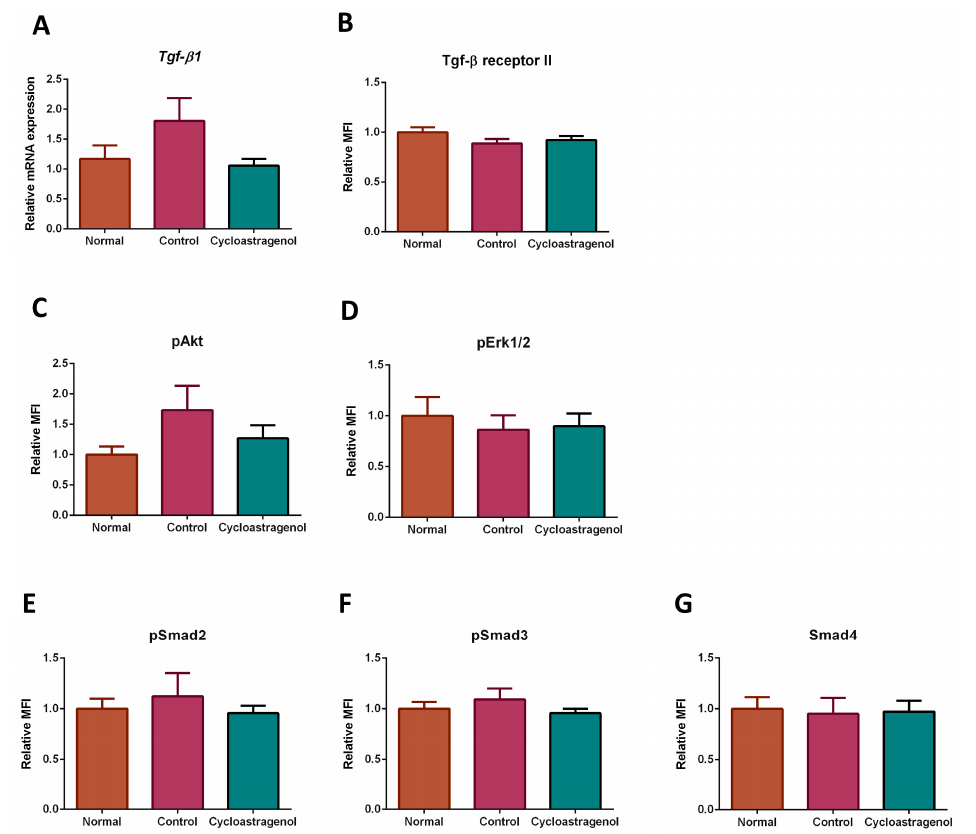
Figure 9. Effects of cycloastragenol (200 mg/kg) on the expression of markers associated with transforming growth factor-beta 1 (TGF- β 1) signaling in the liver of mice treated with carbon-tetrachloride. Relative mRNA expression of TGF- β 1 ( Tgf- β 1 , ( A )) and relative median fluorescence intensity (MFI) of transforming growth factor-beta receptor II (Tgf- β receptor II, ( B )), phosphorylated protein kinase B (pAkt, ( C )), phosphorylated extracellular signal-regulated kinase 1/2 (Erk1/2, ( D )), phosphorylated-Smad2 (pSmad2, ( E )), phosphorylated-Smad3 (pSmad3, ( F )), and Smad4 ( G ) when compared with the normal are shown. Bar graphs and corresponding error bars indicate means and SEM among the same treatment, respectively ( n = 8–10).